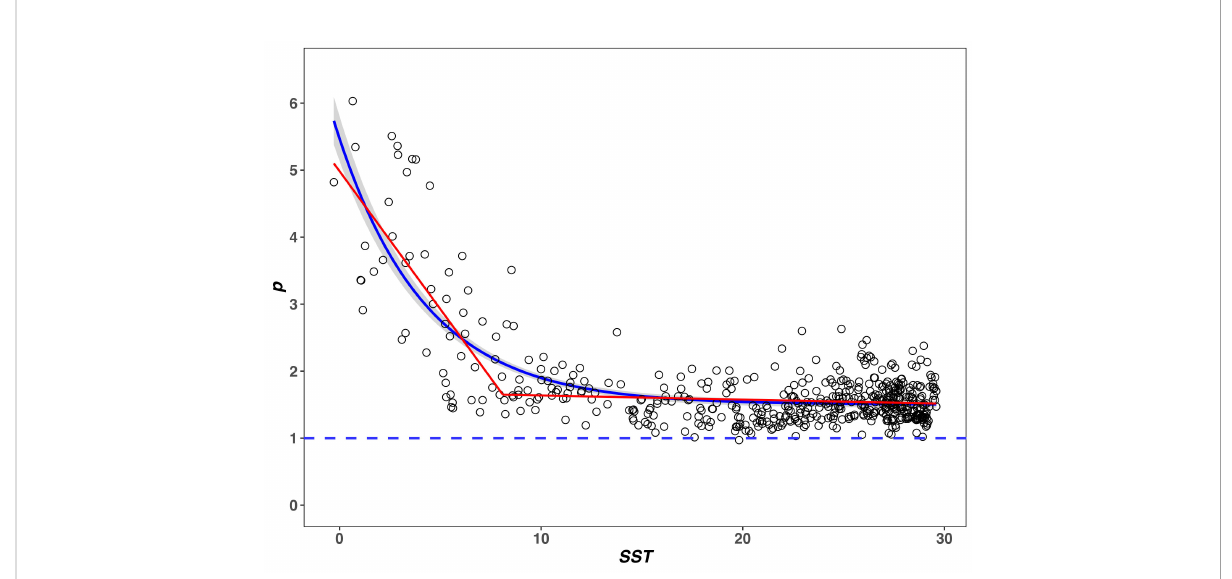
FIGURE 2 Relationships between SST ( T ) and fractal p for the BFD data. The red line represents the result of piecewise regression, noting that p changes in the same direction as T increases ( r p 1 = − 0.69, r p 2 = − 0.11). Non-line regression results are signi fi cant (blue line with gray 99% con fi dence limits, results: y = − 3.970e -0.23 x + 1.501, R 2 = 0.631, P <